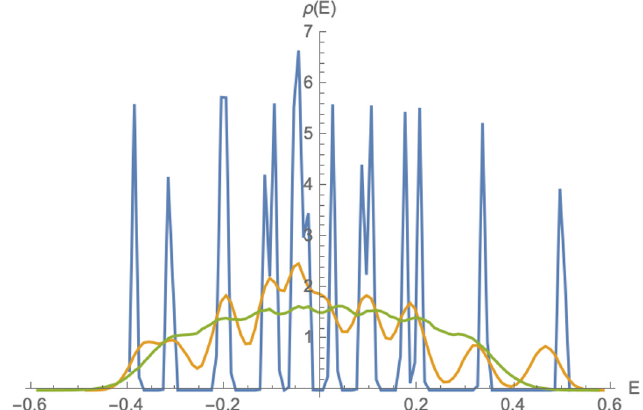
Figure 3 . Density of states ρ ( E ) with σ = 0 . 03 (blue), 0 . 3 (orange), 3 (green). We take N = 8 , q = 4 and J = 1 , and take 50000 samples for averaging. In this plot, the exter- nal coupling J (0) is chosen randomly from the Gaussian probability distribution P ( J (0) i 1 ··· i q